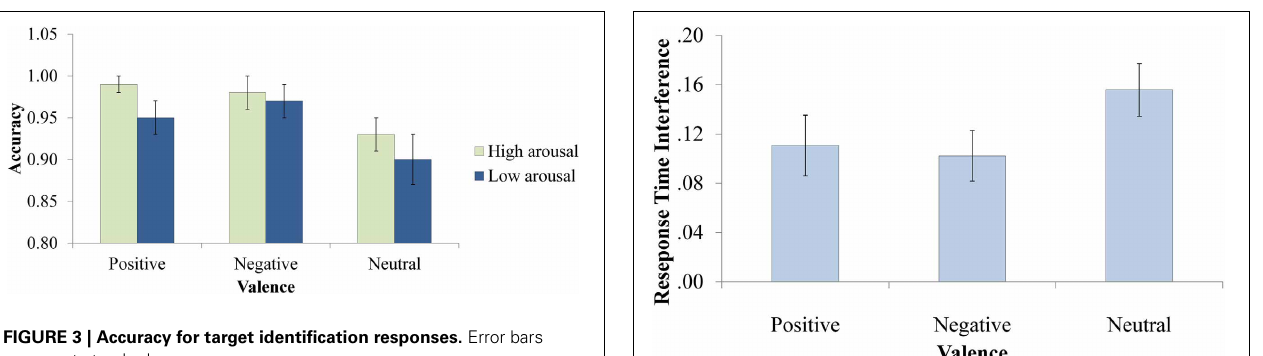
FIGURE 3 | Accuracy for target identification responses. Error bars represent standard errors.